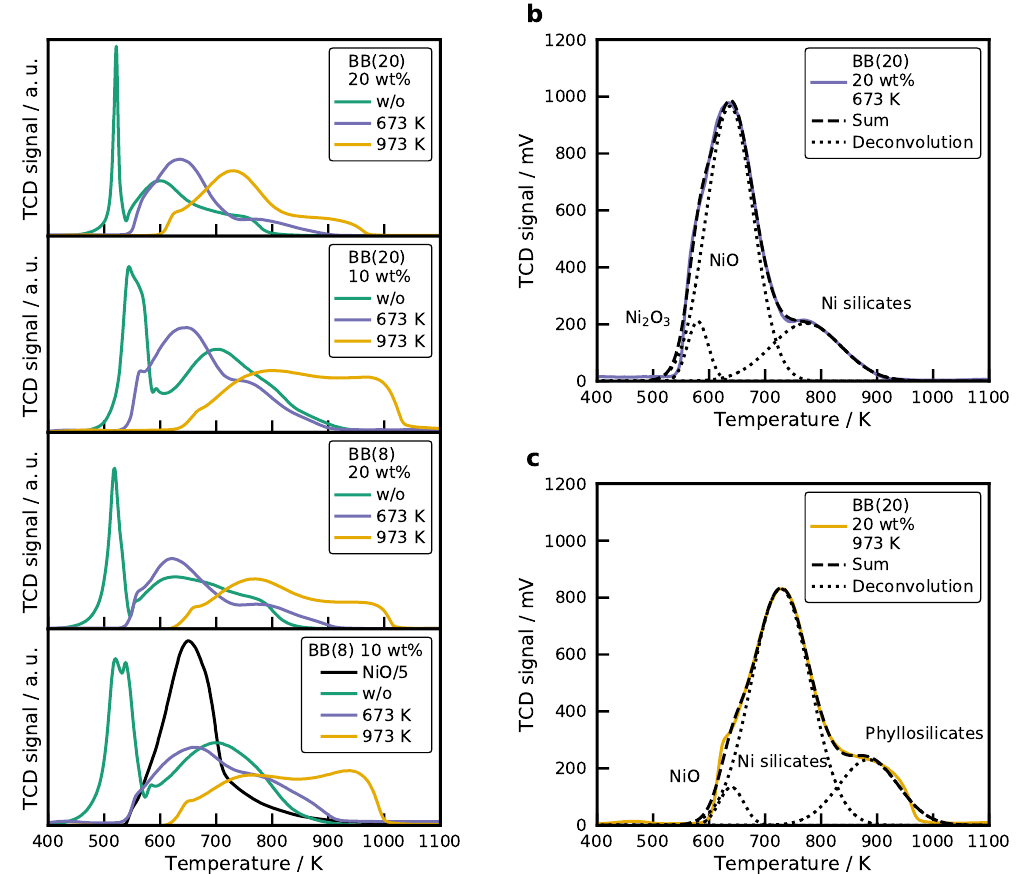
Figure 6. ( a ) Temperature-programmed reduction profiles (TPR) for all Ni/SiO 2 catalysts. TPR profiles of the BB(20) with 20wt% Ni catalyst calcined at ( b ) 673K and ( c ) 973K with a Gaussian deconvolution of the signal. Conditions: m cat = 20mg, β = 10Kmin − 1 , ˙ V H